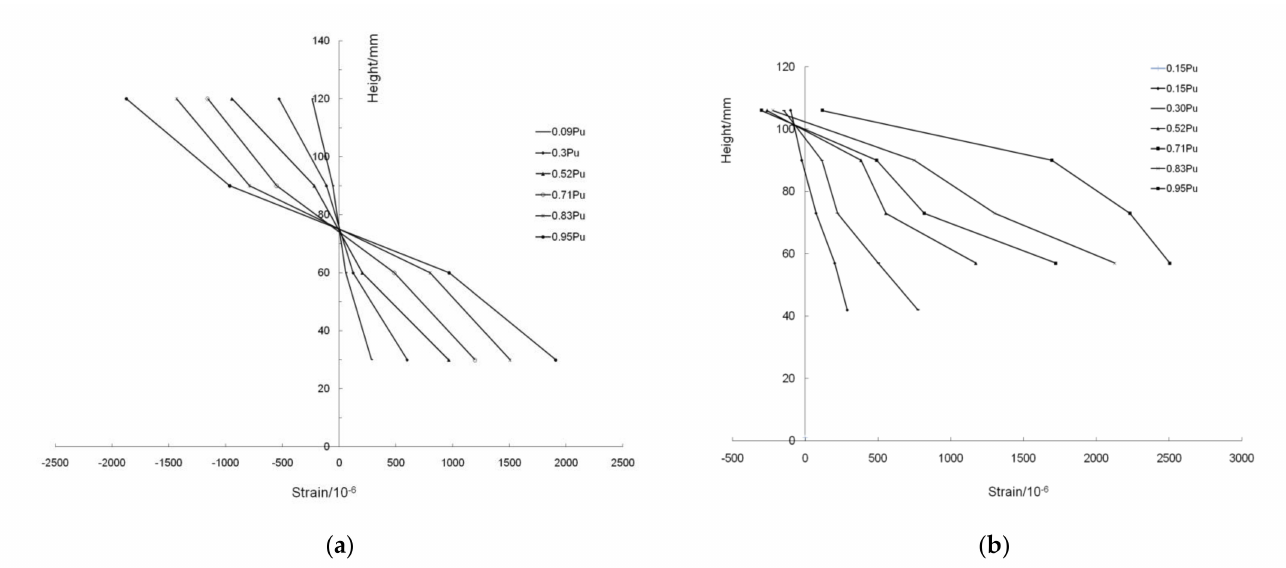
Figure 8. Strain distributions along the height of the slab at different loading stages. ( a ) Foam concrete slab; ( b ) Cold-formed thin-walled C steel